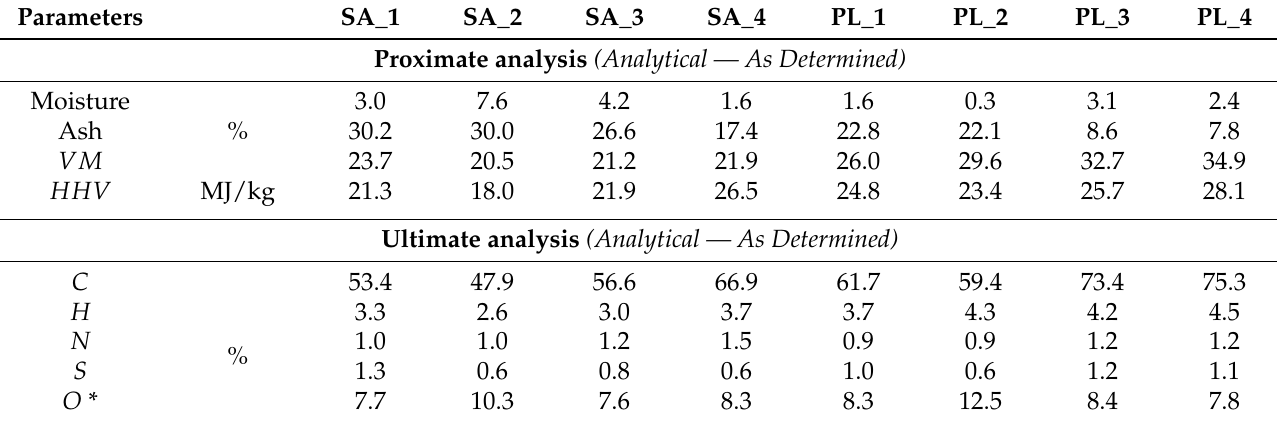
Table 1. Characteristic parameters for the tested